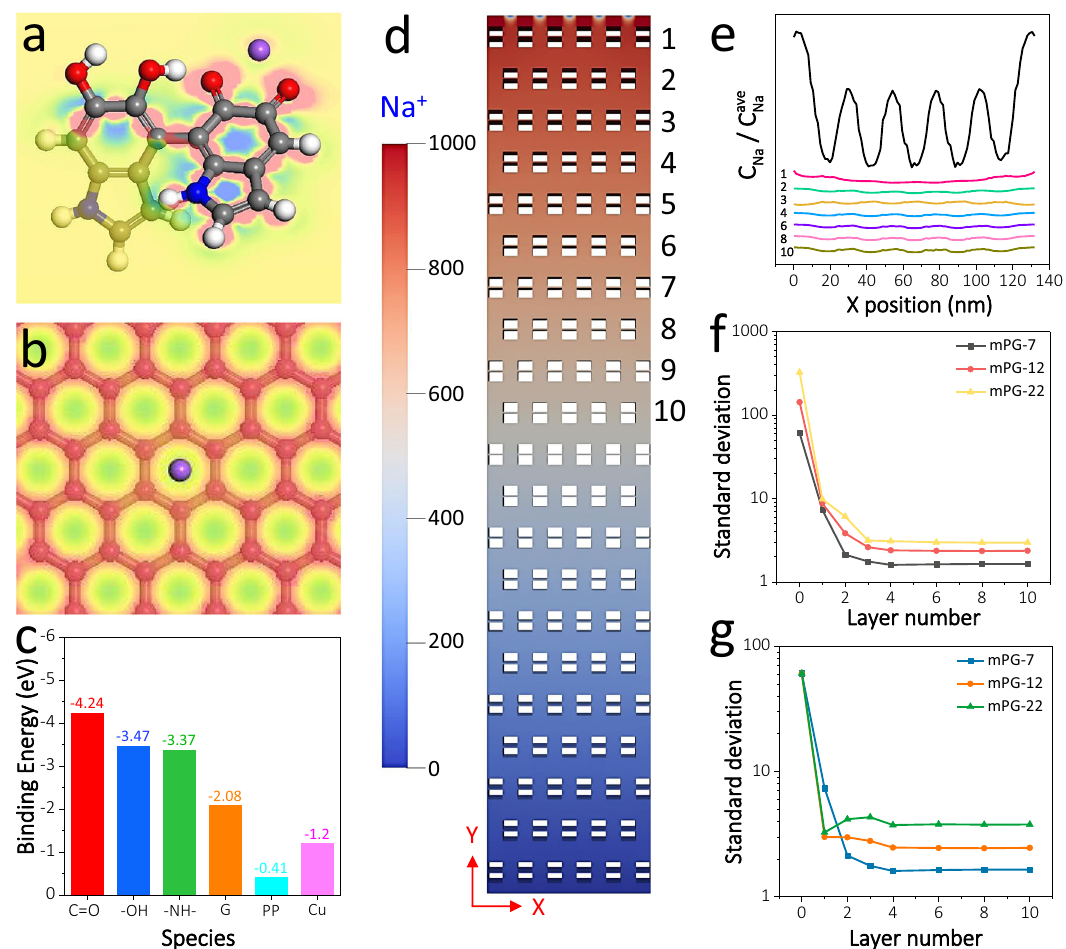
Fig. 3 Sodiophilic nature and Na-ion deposition behavior of s-2D mPG heterostructures by DFT calculation and FVM simulation. a The deformation charge density of polydopamine molecule with Na. b The deformation charge density of graphene with Na. c Binding energies of Na with Cu, PP, graphene, and different functional groups in polydopamine. d Model diagram of Na ions through mPG layer (Inset: the color represents different concentration of Na ions). e The relative concentration of Na ions beneath different mPG layer with same amplitude and period of Na-ion distribution at the entrance. f , g Standard deviation of Na-ion concentration beneath mPG-7, mPG-12, and mPG-22 layers with ( f ) same amplitude and ( g ) same fl uctuation of Na-ion distribution at the